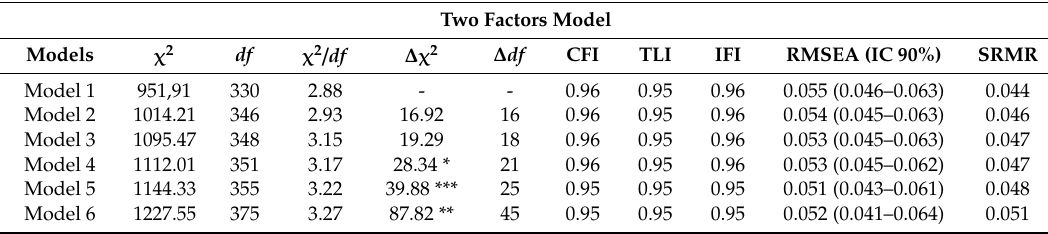
Table 2. Gender Invariance Analysis.